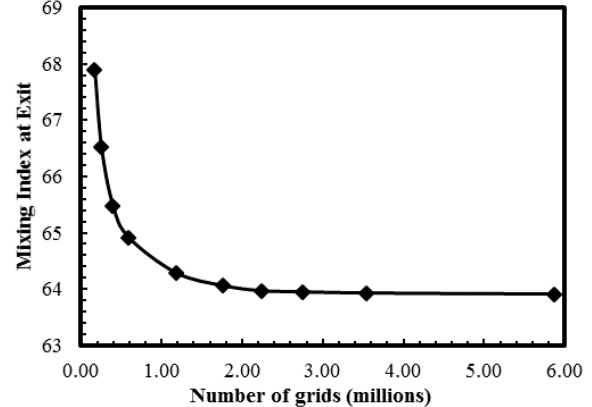
Figure 4. Grid-dependency test for the mixing index at the exit.